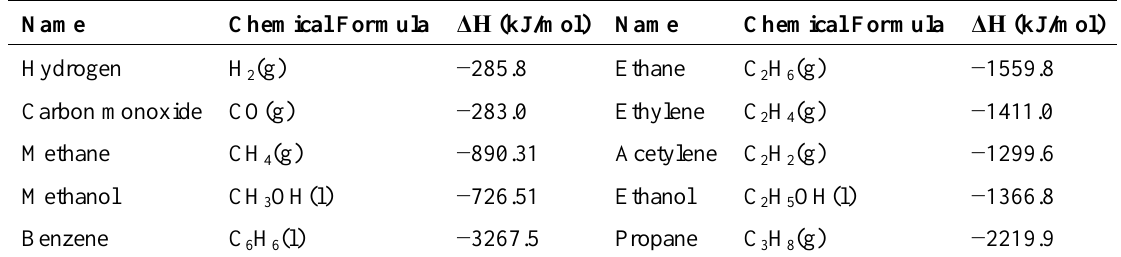
Table 2. Combustion enthalpy of typical inflammable substances in the chemical